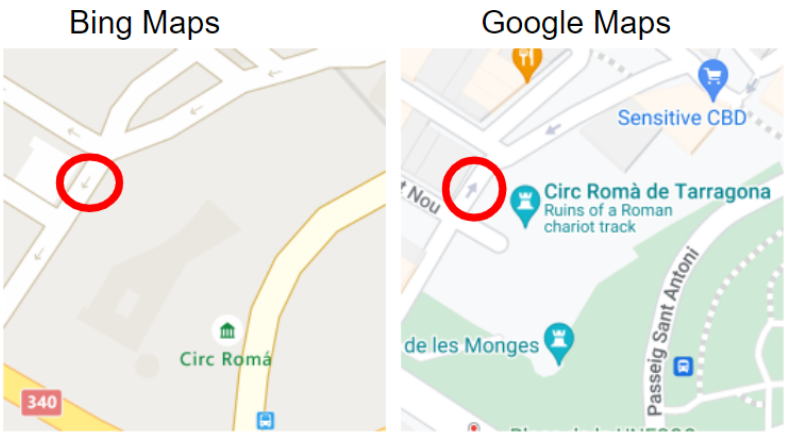
Figure 19. Type 2 (strong discrepancy) example #1-Spain.